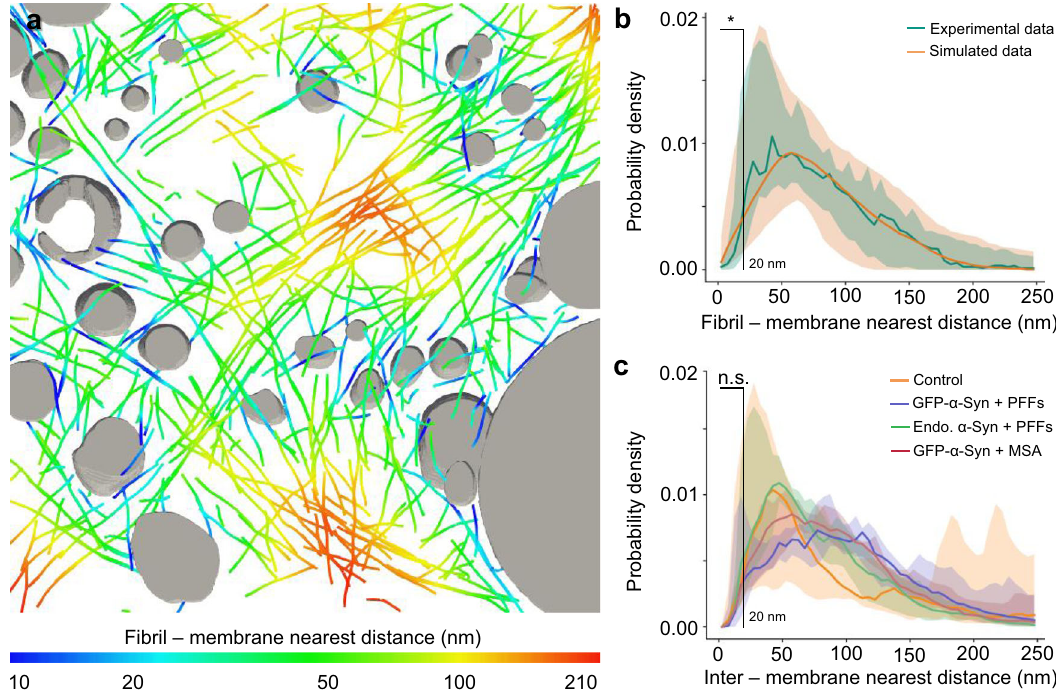
Fig. 4 Quanti fi cation of fi bril-membrane and inter-membrane distances within α -Syn inclusions. a Visualization of fi bril-membrane distances in the tomogram rendered in Fig. 1d. Organelles are shown in gray, and fi brils are color-coded according to their distance to the nearest organelle membrane. b Histogram of nearest distances between a fi bril and a membrane in the pooled experimental data ( n = 15 tomograms, including 6 of GFP- α -Syn + PFFs, 4 of endogenous α -Syn + PFFs, and 5 of GFP- α -Syn + MSA over three biologically independent experiments for all conditions), and in simulations shifting and rotating fi brils from their experimentally determined positions (200 simulations for each experimental tomogram). Solid lines represent the median of all tomograms. The shaded areas represent 5 – 95% con fi dence intervals. Fibril-membrane distances <20 nm are signi fi cantly more abundant in the simulated data ( p = 0.03 by two-tailed Kolmogorov – Smirnov test). See also Supplementary Table 1. c Histogram of inter-membrane nearest distances for all organellar membranes in the tomograms. Inter-membrane distances <20 nm are not signi fi cantly different within α -Syn inclusions than in control untransduced and unseeded cells ( p = 0. 4 by two-tailed Kolmogorov – Smirnov test). Solid lines represent medians, shaded areas represent 5 – 95% con fi dence intervals. n = 5 (untransduced − PFFs), 6 (GFP- α -Syn + PFFs), 4 (endogenous α -Syn + PFFs), and 5 (GFP- α -Syn + MSA) tomograms analyzed over two (untransduced − PFFs) or three biologically independent experiments (GFP- α -Syn + PFFs, endogenous α -Syn + PFFs, and GFP- α -Syn + MSA). The number of tomograms and biologically independent cryo-ET experiments is listed in Supplementary Table 1. A representative image is shown in a . Source data for b and c are provided as a Source data fi The following secondary antibodies were used: Alexa Fluor 488 Af fi niPure Donkey anti-chicken (703-545-155, Jackson ImmunoResearch; 1:250), Alexa Fluor 647 Af fi niPure Donkey anti-chicken (703-605-155, Jackson ImmunoResearch; 1:250), Cy3 Af fi niPure Donkey anti-rabbit (711-165-152, Jackson ImmunoResearch; 1:250), Alexa Fluor 488 Af fi niPure Donkey anti-mouse (715- 545-150, Jackson ImmunoResearch; 1:250), Cy3-conjugated Af fi niPure Goat anti- mouse IgG (115-165-003, Jackson ImmunoResearch; 1:1000), Cy3-conjugated Af fi niPure Goat anti-rabbit (111-165-045, Dianova; 1:1000; RRID: AB_2338003), and HRP-conjugated goat anti-rabbit (A9169, Sigma; 1:5000; RRID: AB_258434). Recombinant α -Syn puri fi cation and fi bril assembly . Recombinant human WT and A53T α -Syn were puri fi ed as follows based on a published procedure 25 (see https://edmond.mpdl.mpg.de/imeji/collection/dBIbxxKvWaYMpyhI for a detailed protocol). BL21 (DE3) Escherichia coli (Agilent) were transformed with pT7-7 α -Syn or pT7-7 α -SynA53T. Protein expression was induced by 1mM IPTG for 4h. Bacteria were harvested and pellets were lysed in high salt (HS) buffer (750mM NaCl, 50mM Tris, pH 7.6, and 1mM 2,2 ′ ,2 ″ ,2 ′′′ -(ethane-1,2-diyldinitrilo) tetraacetic acid (EDTA)). The lysate was sonicated for 5min and boiled subsequently. The boiled suspension was centrifuged, the supernatant dialyzed in 50mM NaCl, 10mM Tris, and 1mM EDTA, and puri fi ed by size-exclusion chromatography (Superdex 200). Fractions were collected and those containing α -Syn were combined. The combined fractions were applied onto an anion exchange column (MonoQ). α -Syn was puri fi ed by a gradient ranging from 50mM to 1M NaCl. Fractions containing α -Syn were combined and dialyzed in 150mM KCl and 50mM Tris, pH 7.6. For fi bril assembly, puri fi ed α -Syn monomers (5mg/ml) were centrifuged at high speed (100,000 × g ) for 1h. The supernatant was transferred into a new reaction tube, incubated with constant agitation (1000r.p.m.) at 37°C for 24 h. The resulting fi brils were diluted 1:20 in PBS and sonicated for 60s (0.5 s on, 0.5s off) using a Branson soni fi er. The presence of α -Syn fi brils was con fi rmed by negative